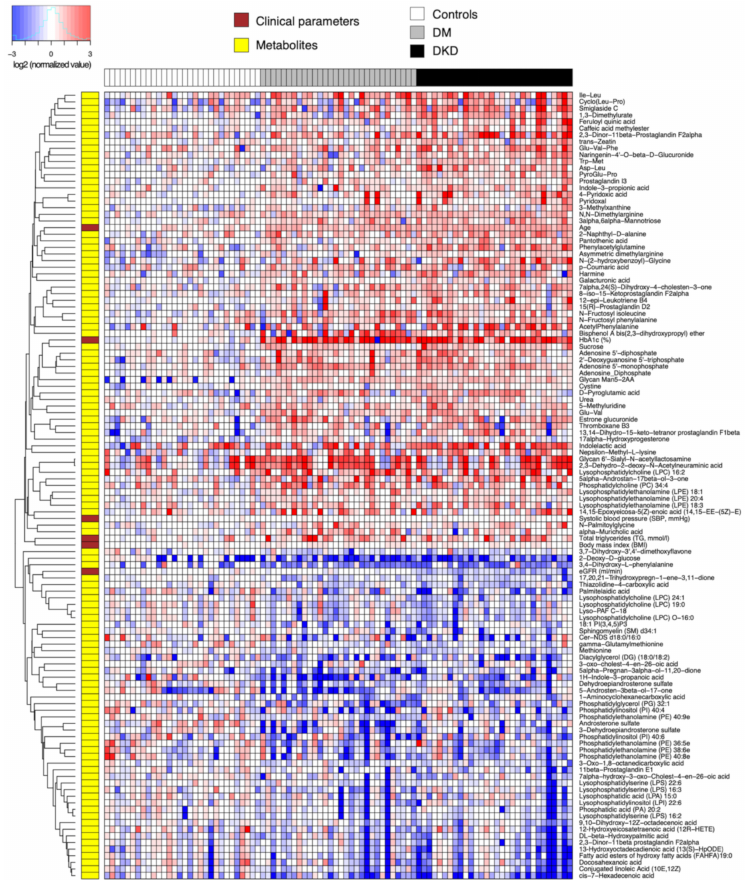
Figure 1. Heatmap of relative abundance values (log-transformed, base 2) of endogenous compounds differentially abundant between 60 DM patients and 30 controls. Data were normalized by the median of the 30 control samples in each